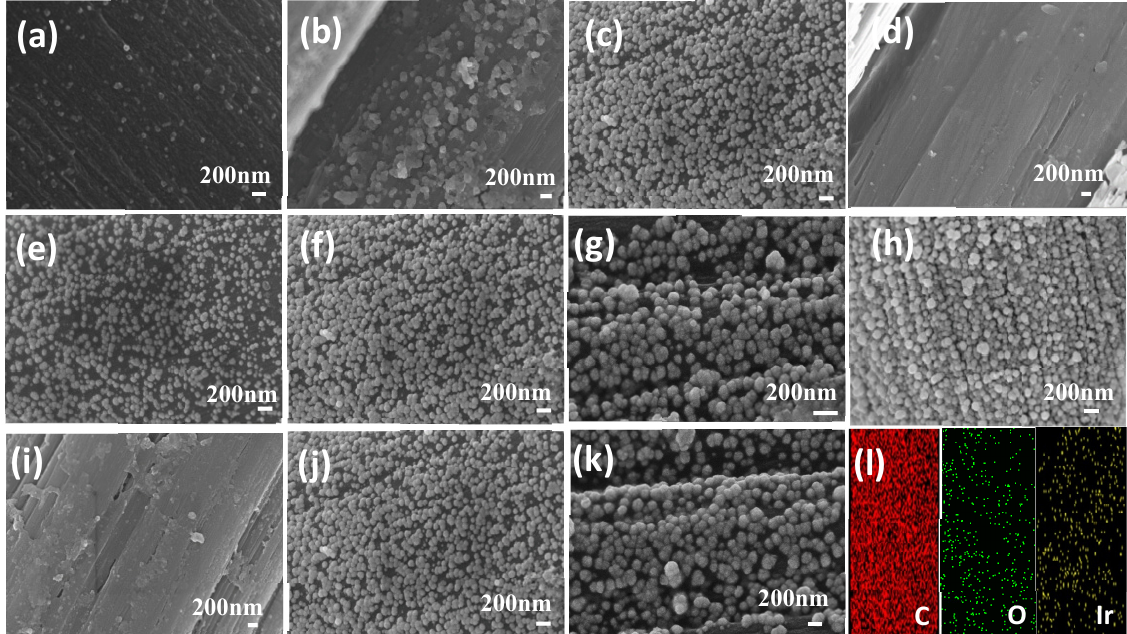
Figure 2. SEM images of catalysts prepared at different electroplating temperatures, times, and current densities. ( a – d ) The electroplating temperatures were 25 ◦ C, 75 ◦ C, 85 ◦ C, and 95 ◦ C at 2 mA cm − 2 for 2 h, respectively. ( e – h ) The electroplating times were 1 h, 2 h, 4 h, and 6 h at 2 mA cm − 2 and 85 ◦ C, respectively. ( i – k ) The current densities were 1 mA cm − 2 , 2 mA cm − 2 , and 3 mA cm − 2 at 85 ◦ C for 2 h, respectively. ( l ) Mapping images of catalyst fabricated at 2 mA cm − 2 , 85 ◦ C for 2 h. The XRD patterns of Ir-based catalysts obtained at different electroplating tempera- tures are given in Figure 3a. The characteristic peaks of all samples from different elec- troplating temperatures were well matched with XRD standard cards, PDF#41-1487 and PDF#06-0598, corresponding to C and Ir, respectively. The peak at 26.38 ◦ and 44.39 ◦